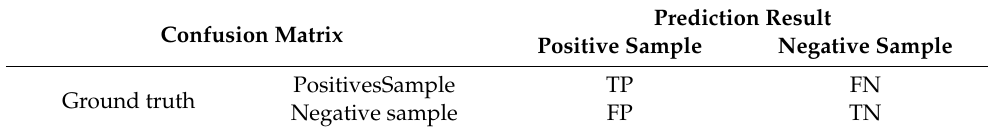
Table 4. Schematic diagram of confusion